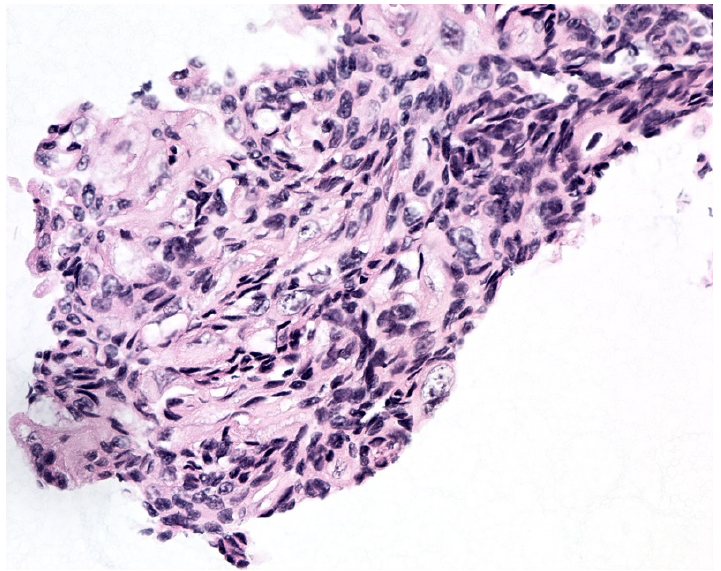
Figure 6. Stone atypia in a cell block preparation. The fragment demonstrates urothelial cells with irregular nuclear contours and hyperchromasia due to the overlapping of nuclei in a patient with a history of recurrent bladder stones. However, no papillary formations can be seen, and cells in the upper left corner show bland chromatin distribution and lack of hyperchromasia. Given the history of stones and focal cytologic atypia, the findings are negative for high-grade urothelial carcinoma.